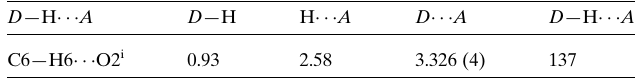
Table 1 Hydrogen-bond geometry (A˚ , (cid:3) ).